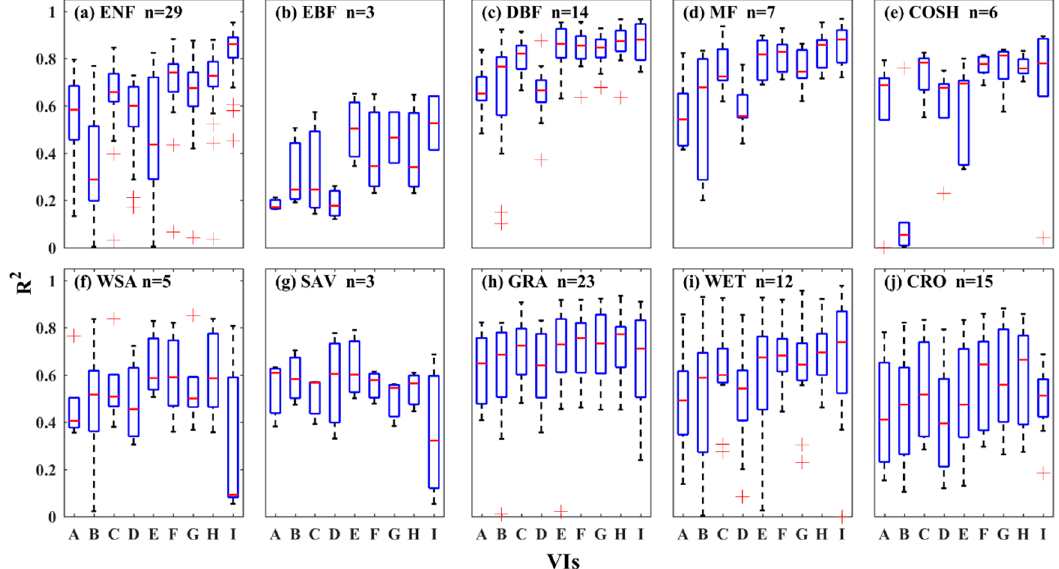
Figure 2. The boxplots of the R 2 values for the relationships between MODIS-derived VIs and tower GPP at the monthly scale across all sites within each biome. The letters on the x axis stand for: A - NDVI, B - EVI, C - EVI2, D - NDVI BRDF , E - EVI BRDF , F - EVI2 BRDF , G - NIR V , H - NIR V, BRDF, and I - MODIS GPP. The biome types are as follows: evergreen needleleaf forest (ENF); evergreen broadleaf forest (EBF); deciduous needleleaf forest (DNF); mixed forest (MF); closed and open shrublands (COSH); woody savannas (WSA); savannas (SAV); grasslands (GRA); wetlands (WET); croplands (CRO).